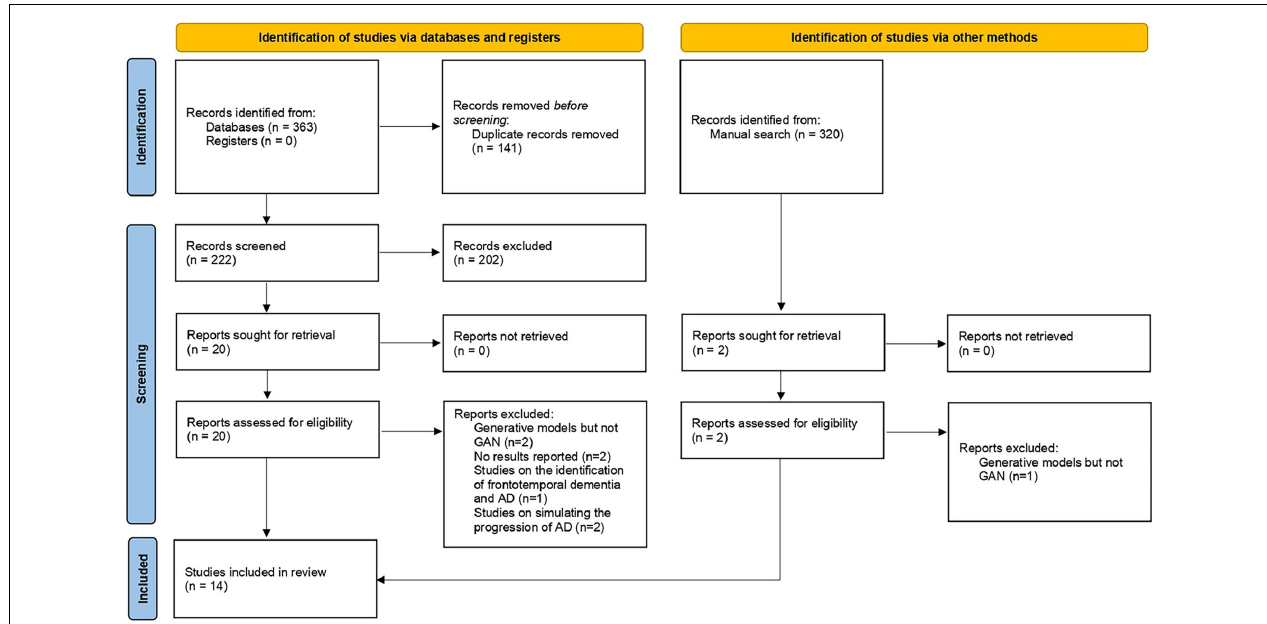
FIGURE 1 | Flowchart of the study selection process (PRISMA flow